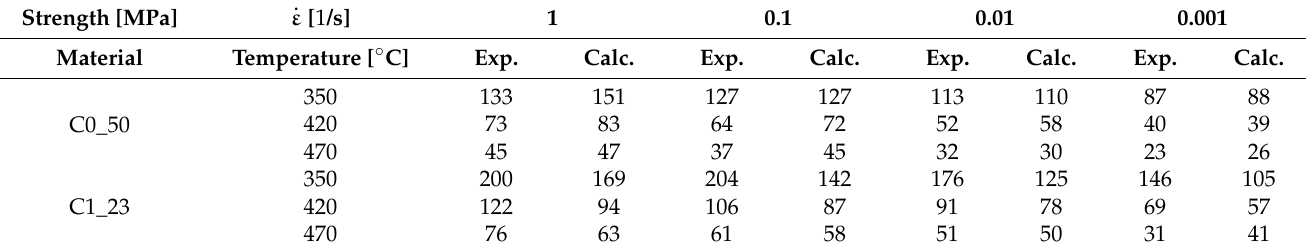
Table A2. Fitted Feret diameter of θ -Al 2 Cu particles and the resulting Orowan strength contribution Δσ OS.